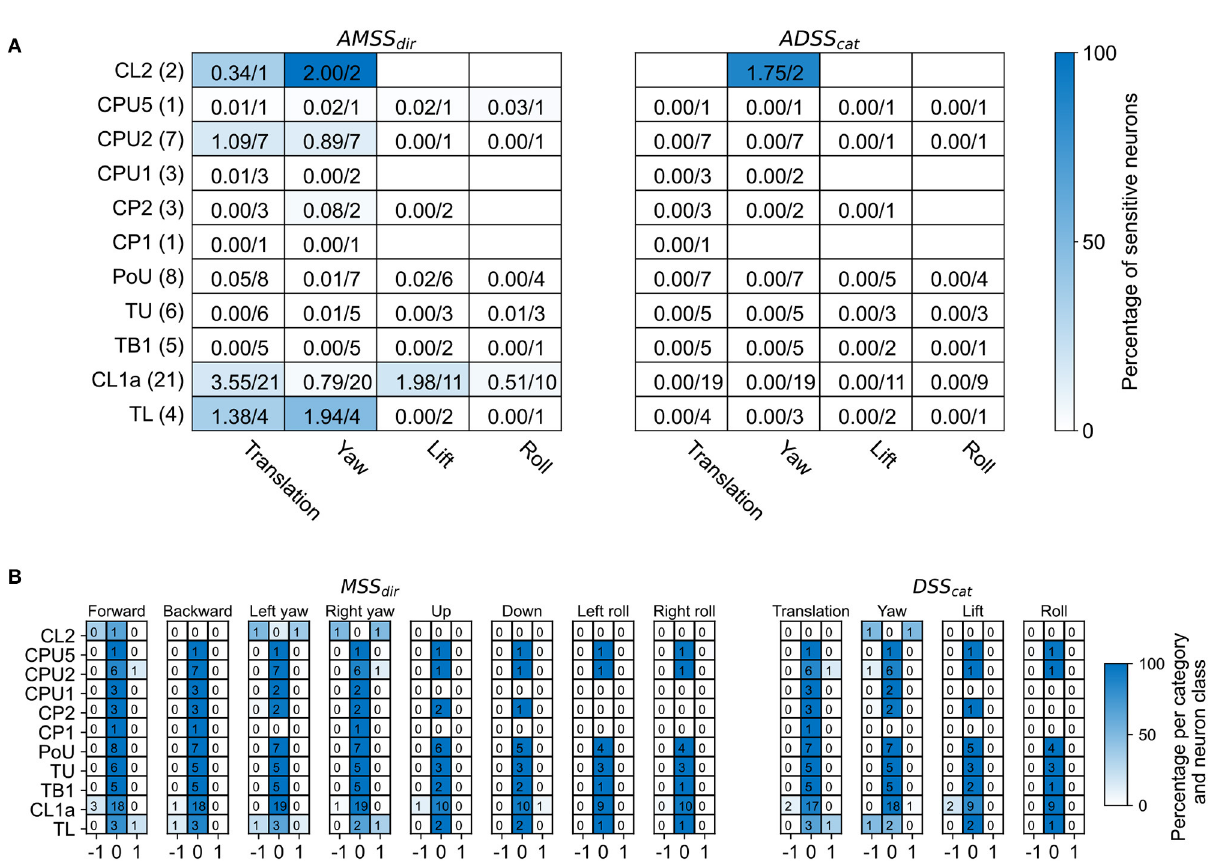
FIGURE3 Overview of motion sensitivity and direction selectivity of all recorded neurons. (A) Absolute motion sensitivity scores per motion direction ( AMSS dir , left) and absolute direction selectivity scores per motion direction category ( ADSS cat , right), summed over neuron cell types. Absolute motion sensitivity scores take values between 0 and 1, with values close to 0 indicating no motion sensitivity and values close to 1 indicating motion selectivity, disregarding whether the neuron responds with an increase or decrease in activity. Absolute direction selectivity scores take values between 0 and 1, with values close to 0 indicating no direction selectivity and values close to 1 indicating direction selectivity, disregarding which motion direction elicits greater firing rates. Each cell holds the (rounded) sum of response scores over neuron cell types. Numbers are given as sums of scores over the total number of tested neurons. The fractions of summed scores and total possible scores are also indicated by the background color. The total number of recorded neurons for each neuron class is indicated in parentheses. Empty cells mean that no neuron was tested with the respective stimulus. (B) Distribution of motion sensitivity scores per motion direction ( MSS dir , left) and direction selectivity scores per direction category ( DSS cat , right), both per neuron class. Cell shading codes for the fraction of summed scores and total possible